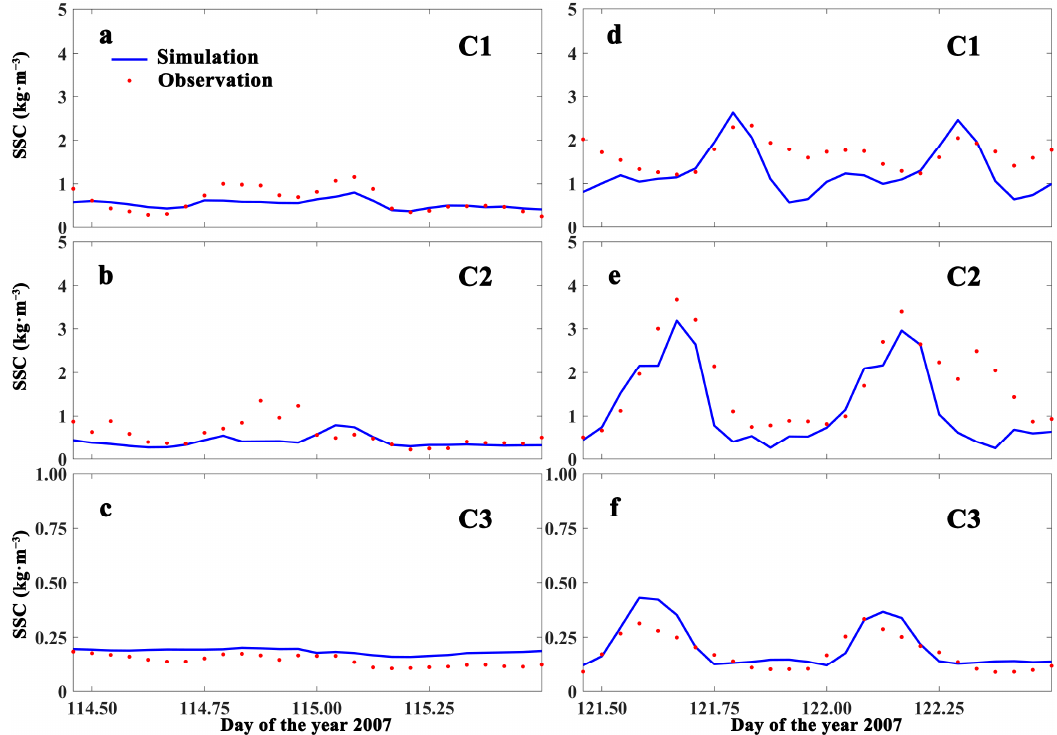
Figure 5. Observed (dot red line) and simulated (solid blue line) vertical averaged salinity (PSU) during ( a – c ) neap tide and ( d – f ) spring tide at the C1~C3 stations. Table 2. General performance ratings [49].